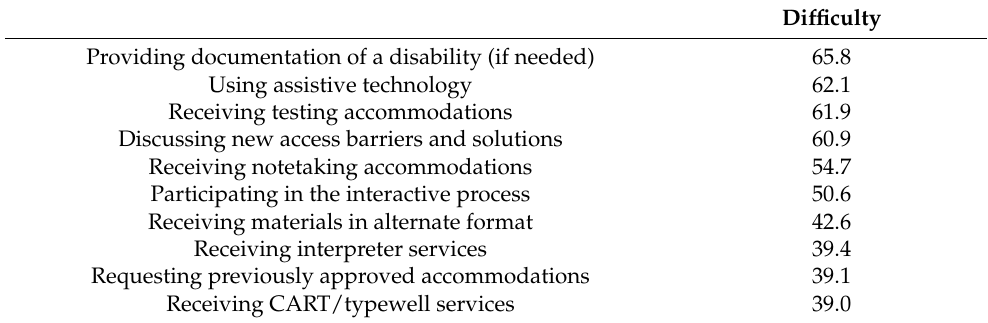
Table 3. Disability resource professionals’ perceived support service challenges for students with disabilities and disability resource office services during COVID-19 (two months into pandemic, n = 535), by